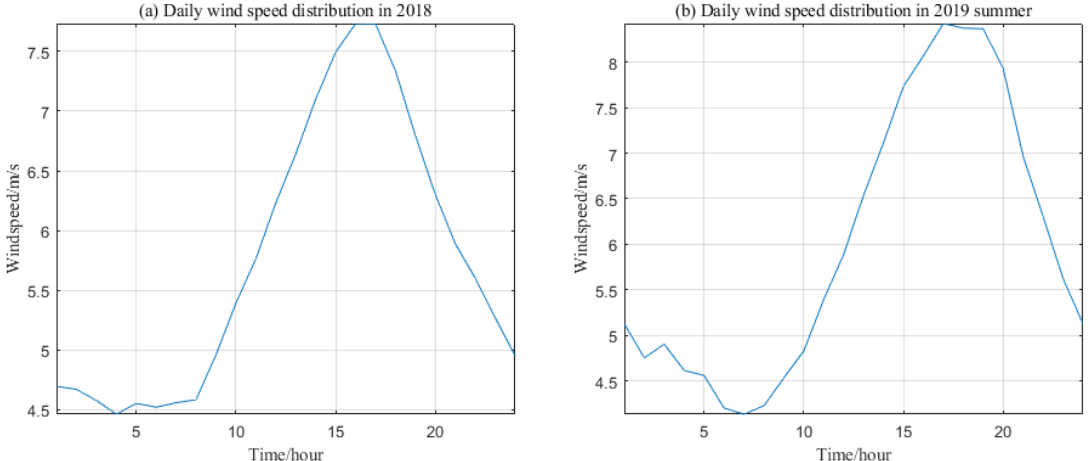
Figure 3. Daily average wind speed variation of the studied area in summer ( a ) 2018 ( b ) 2019.